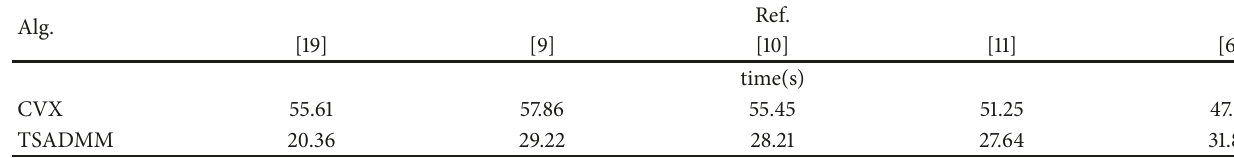
Table 10: Time comparison between CVX and TSADMM with different trip times from [6, 9–11, 19]. Alg.